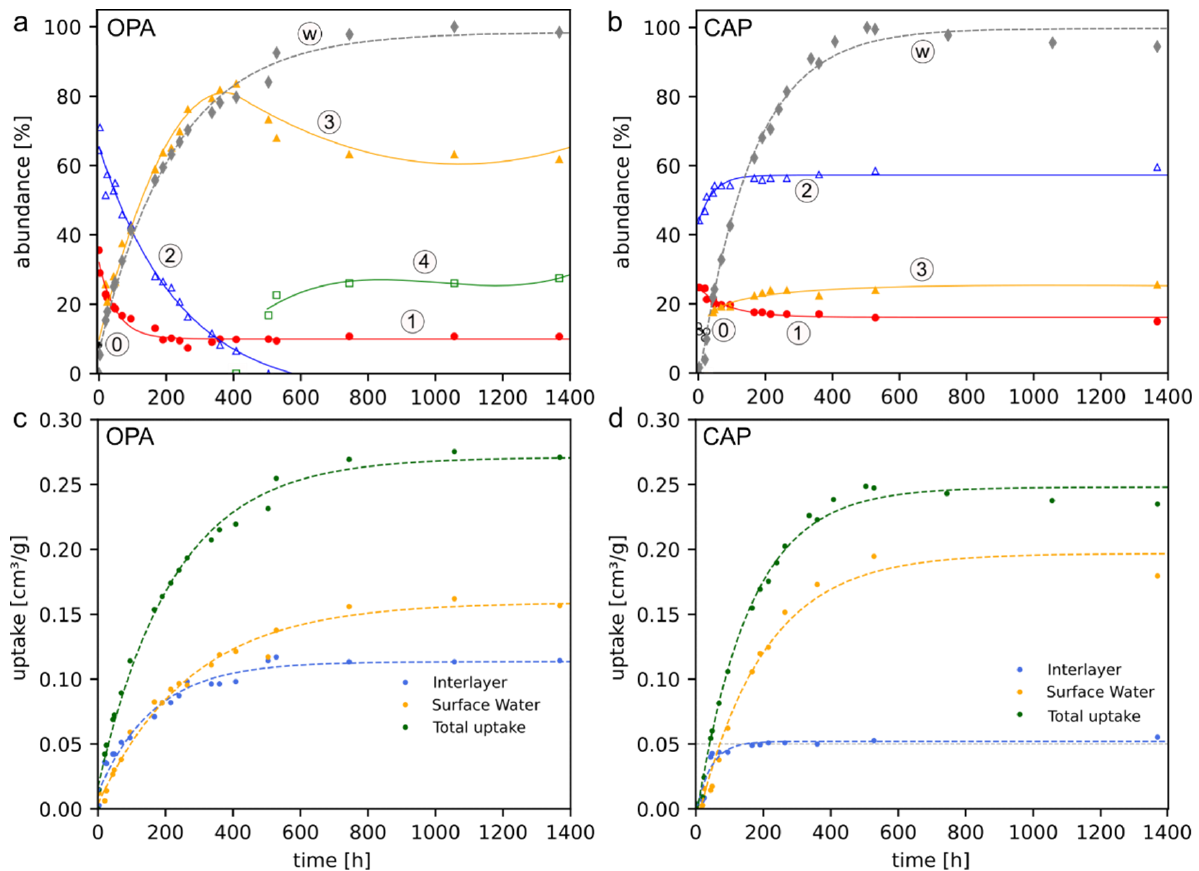
Figure 5. Relative abundance of water-layers developed (a,b) and the location of stored water (c,d) during the hydration of bentonite within the two wet cell experiments. The numbers of water layers (0, 1, 2, 3, 4) are shown in circles. ( a ) SD80 infiltrated by Opalinus clay pore water, ( b ) SD80 infiltrated by diluted cap rock brine, ( c ) partitioning of interlayer and non-interlayer (surface and pore) water in SD80 infiltrated by Opalinus clay pore water, ( d ) partitioning of interlayer and non-interlayer (surface and pore) water in SD80 hydrated by diluted cap rock brine. The total water uptake curve (w) is normalized to